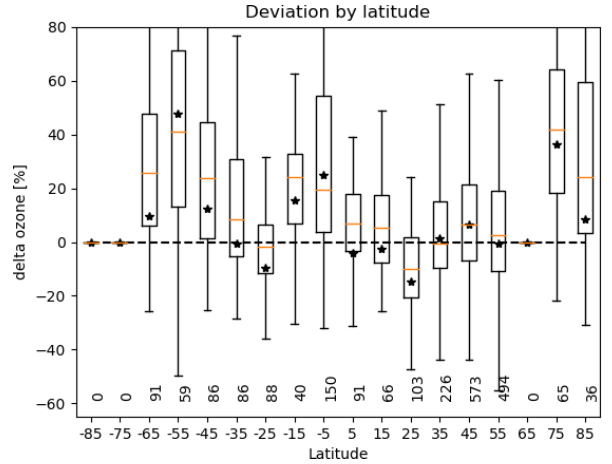
Figure 10. Box and whisker plot showing median deviations (red line) between S5P-BASCOE and the sonde data for 10 ◦ latitude bands and the time period between April 2018 and October 2020. The boxes represent the 25th and 75th percentile, and the stars in- dicate the mean deviation of the tropospheric observations closest to the stations. The number at the bottom indicates the amount of comparisons per latitude band.